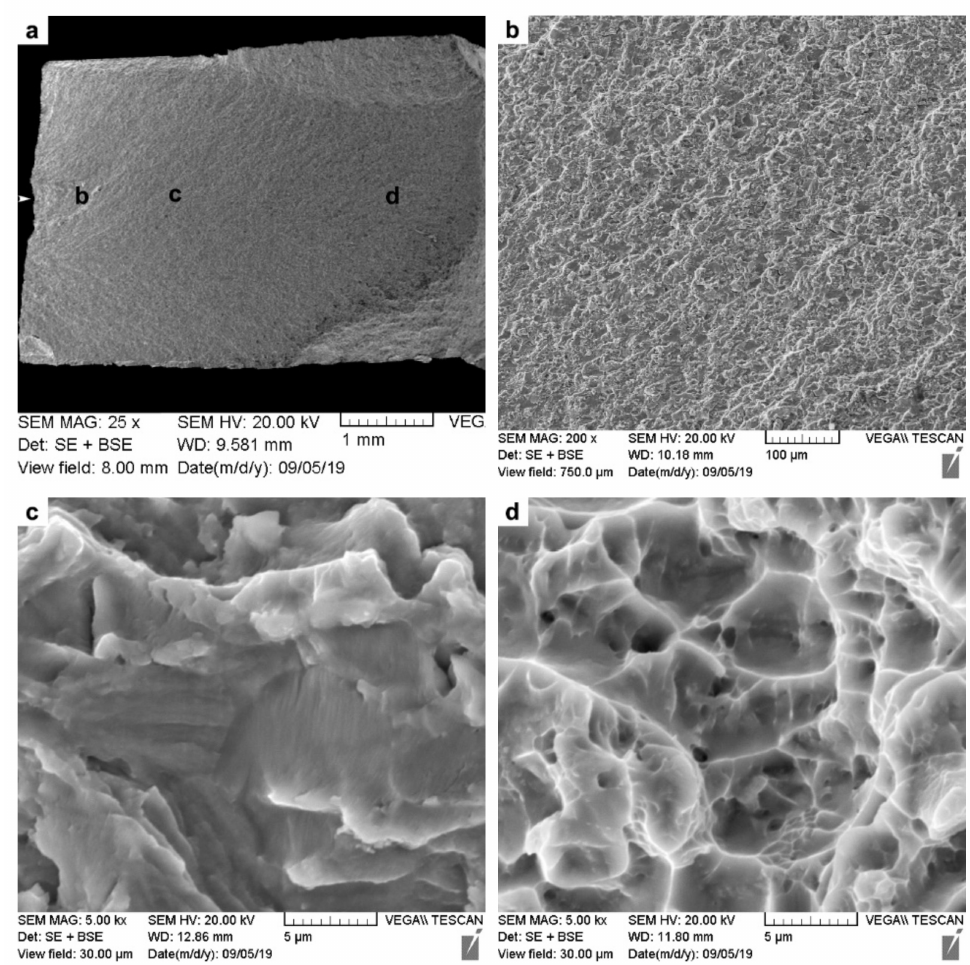
Figure 14. SEM images of the HCF fatigue fracture surfaces of the SRAed Ti-6242 welds: ( a ) overview giving locations of ( b ) early crack growth region, ( c ) stable crack growth region, and ( d ) tensile overload or fast fracture